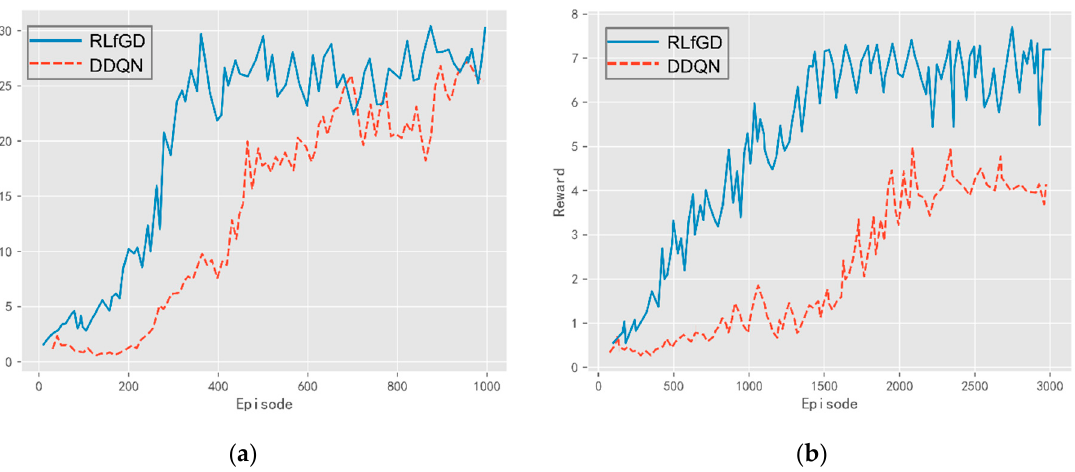
Figure 8. The comparison results of the average episode rewards. ( a ): The performance of different algorithms on the highway. ( b ): The performance of different algorithms in the intersection envi- ronment.